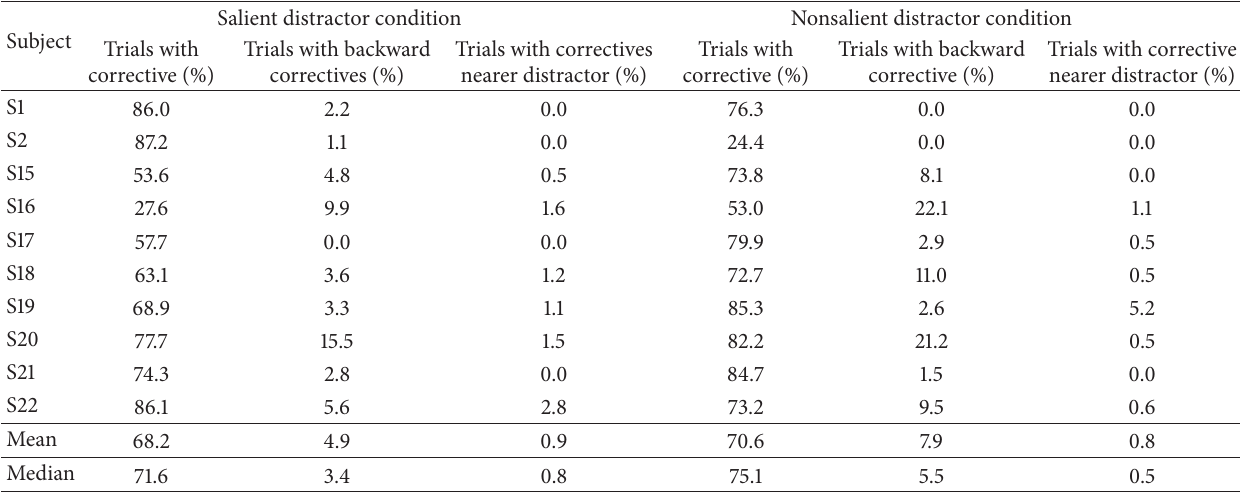
Table 2: Corrective saccades in Experiment 2. The percentage of adaptation trials with corrective saccades for the salient distractor and non salient distractor condition, respectively, and the percentage of those that were in the direction of the distractor and that landed nearer the distractor compared to the saccade